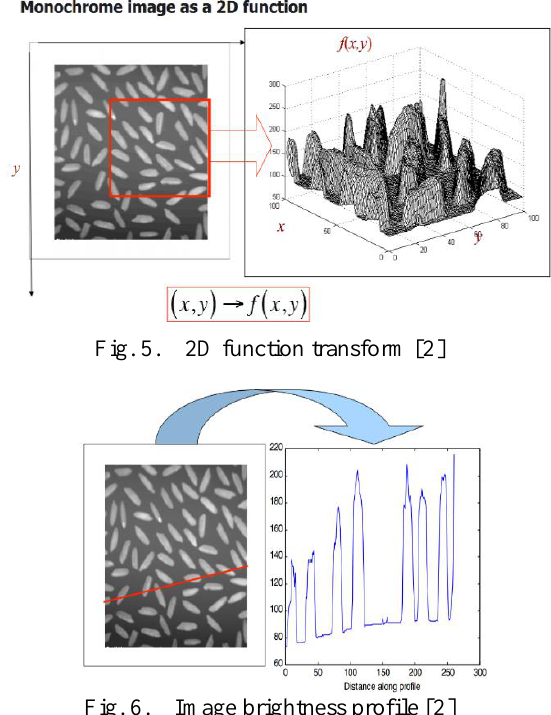
Fig. 6. Image brightness profile